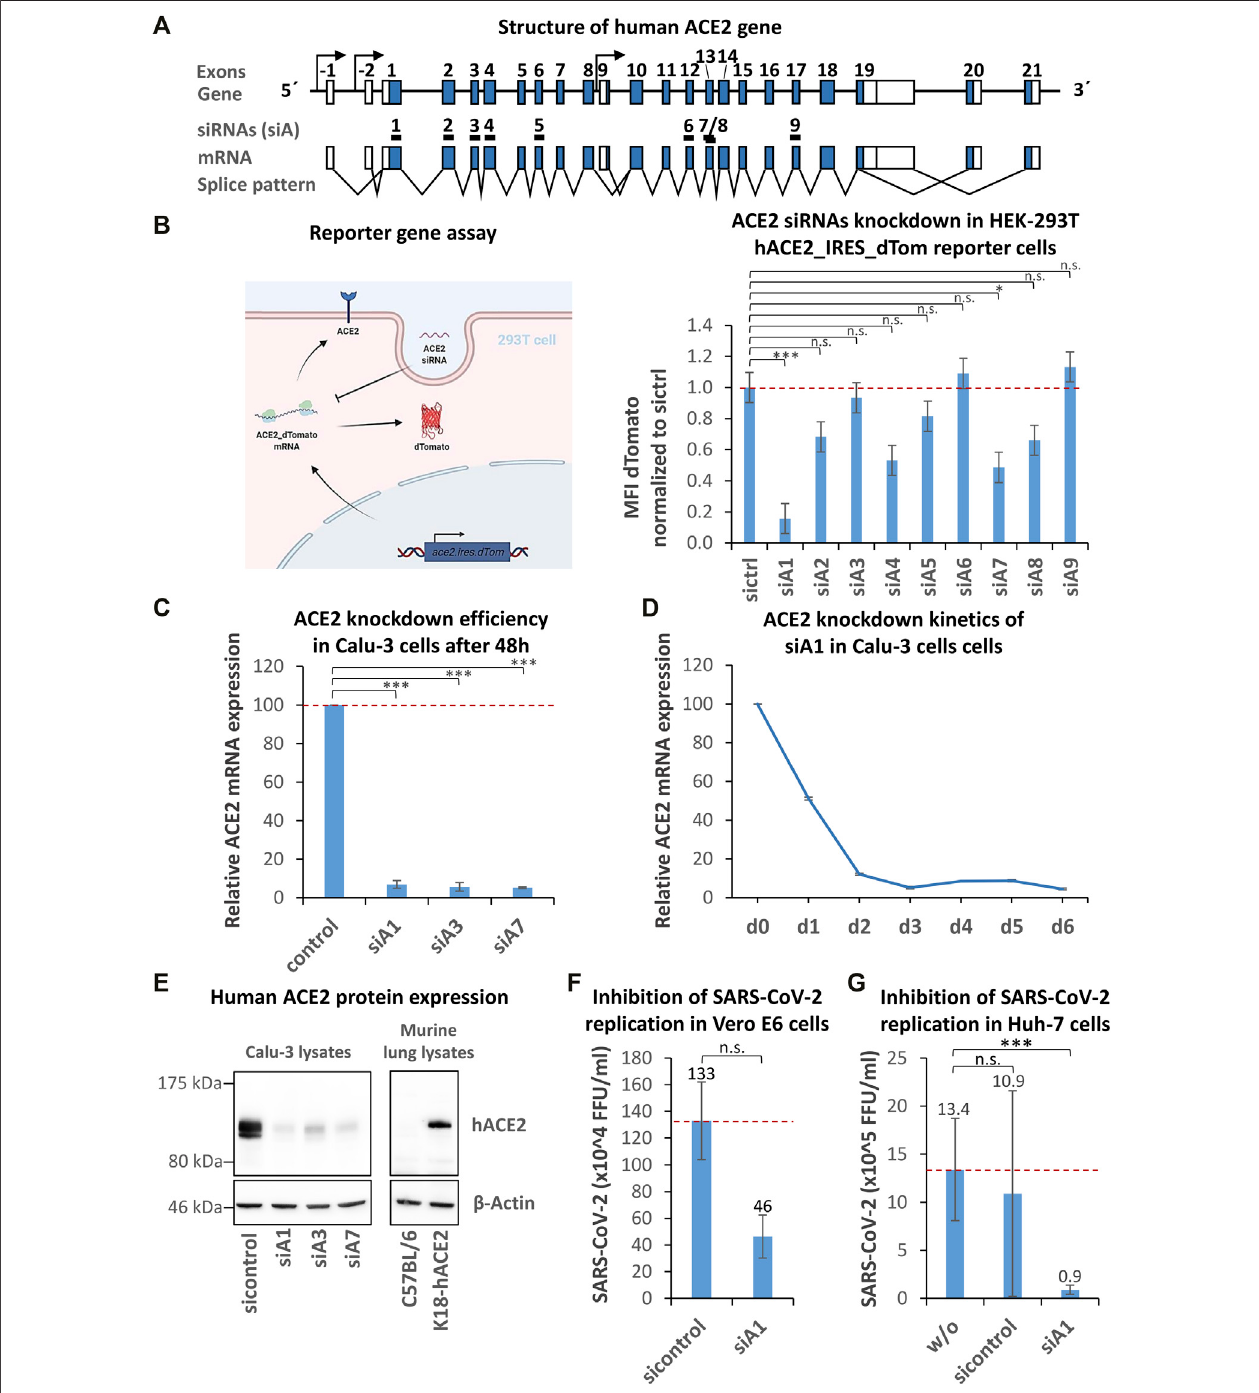
FIGURE1 | Identi fi cation,selection,andvalidationofhumanACE2speci fi csiRNAscapabletoinhibitSARS-CoV-2entry. (A) SchematicrepresentationofthehumanACE2 gene. The structure of the human ACE2 gene was determined by database analyses (https://genome-euro.ucsc.edu, reference mRNA variants: ENST00000678046.1, ENST00000679278.1, ENST00000677282.1, ENST00000427411.2, ENST00000678073.1, and ENST00000252519.8). From two regions spanning exon 1 – 8 and exon 10 – 18,ninedifferentsiRNAs(siA1-9)wereselectedbyalgorithms.Codingexonsareshownasblueboxes,the5 ′ -and3 ′ -UTRsareindicatedbywhiteboxesandintronsare symbolizedbyblacklines.Putativepromotersandtranscriptionstartsitesaresymbolizedbyarrows.Blackboxes(numbered1 – 9)marksiRNAtargetregions. (B) Identi fi cationof themosteffectiveACE-2siRNAusingareportergeneassay.AhACE2/dTomatoexpressingreportercellline(293T_hACE2_dTom)wasgeneratedbylentiviraltransduction.The reporter gene ’ s function is visualized by a cartoon. The reporter cells were transfected with ACE2 siRNAs by lipofection and the dTomato expression was determined by fl ow cytometry after 72 h. Data represent the mean ± s.d. of n = 3 biological replicates. Signi fi cance: not signi fi cant (n.s.); p ≤ 0.05 (*), p ≤ 0.001 (***); Tukey post ANOVA Test